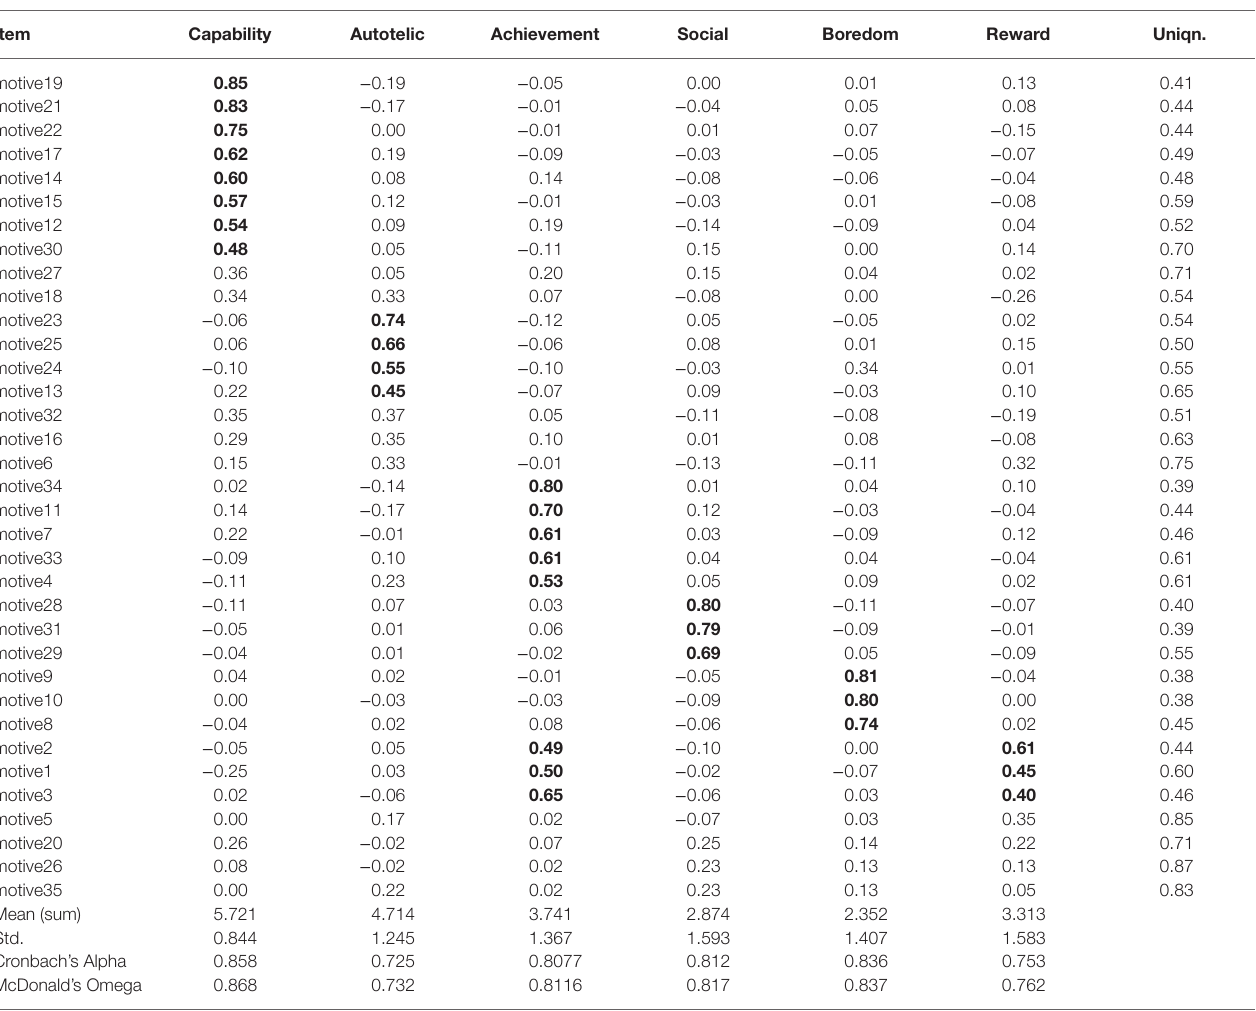
TABLE 2 | Full factor loading table and uniqueness for the 35 Motives for Autonomous Learning inventory.